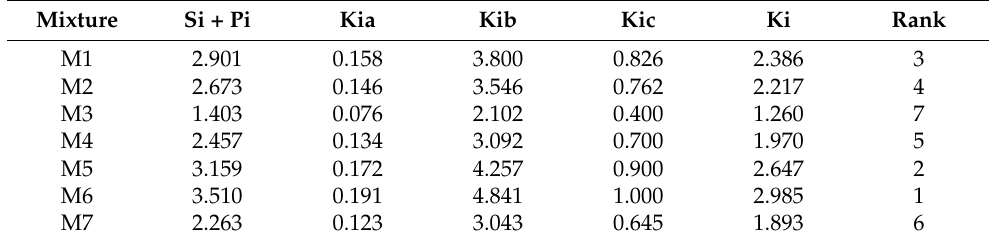
Table 13. Results after applying the CoCoSo method.